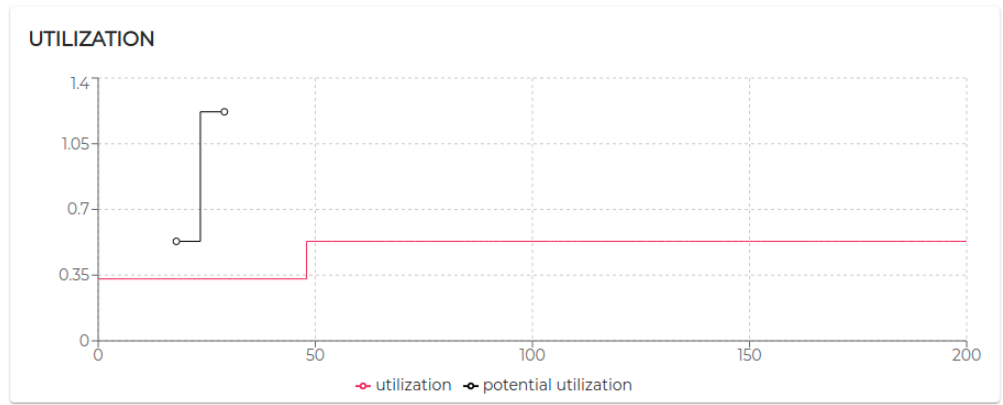
Figure 15. Agents Utilization over the simulated time [0–200 s] in scenario S3rt; y-axis: utilization (adimensional); x-axis: time (seconds).